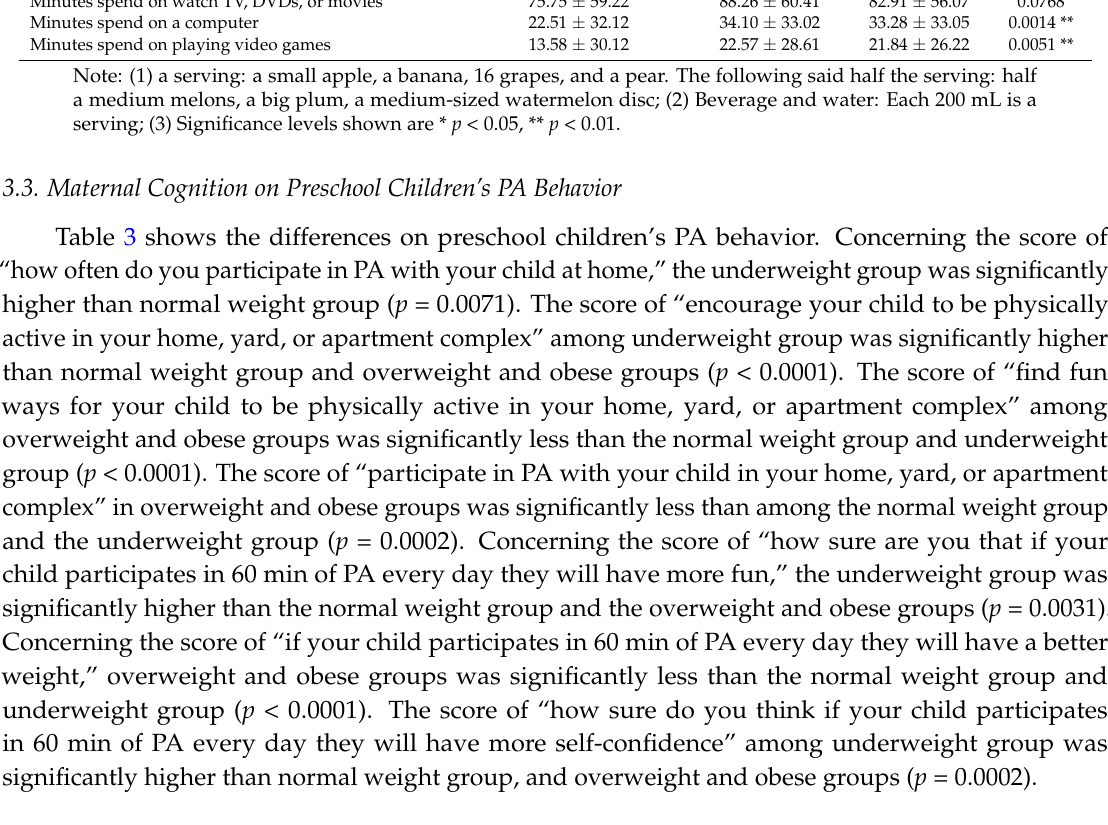
Table 3. Maternal Social Cognitive on Preschool Children’s PA Behaviors by children’ weight status (Mean ±